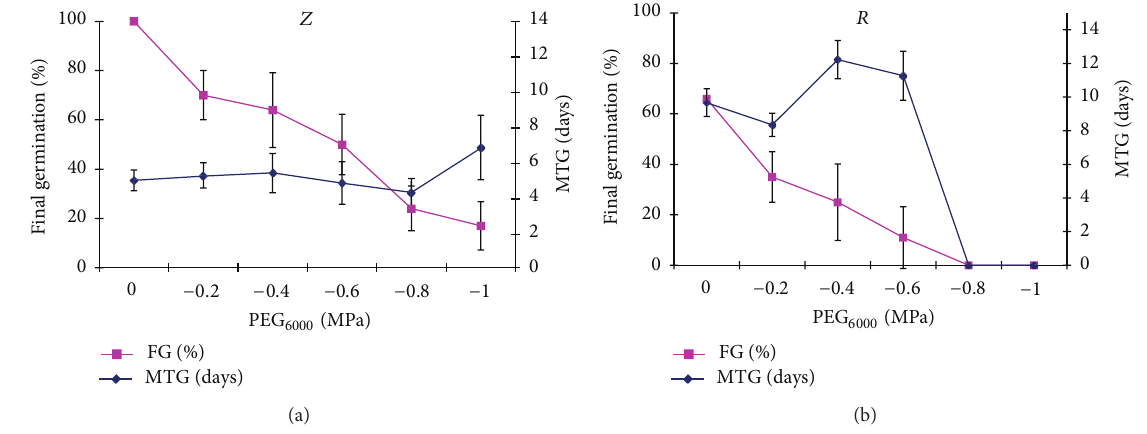
Figure 4: Variation of the final germination percentages (%) and the mean time to germination (MTG, days) of Ziziphus lotus ( 𝑍 ) and Rhus tripartitum ( 𝑅 ) seeds ( 𝑛 = 5 ) at different PEG 6000 solutions of different osmotic potentials (0 to −